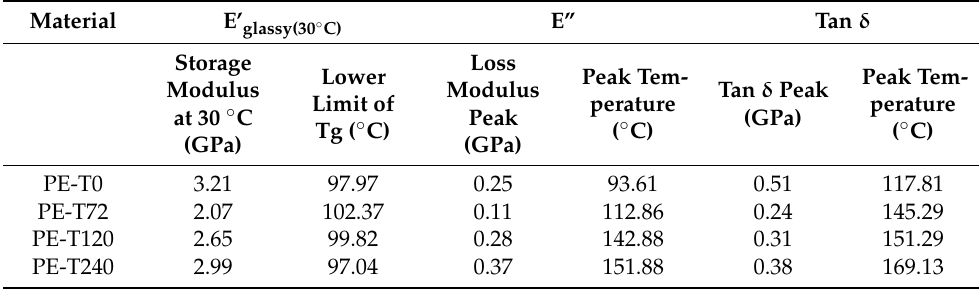
Table 3. DMA parameters obtained for plain epoxy, aged at high temperature and